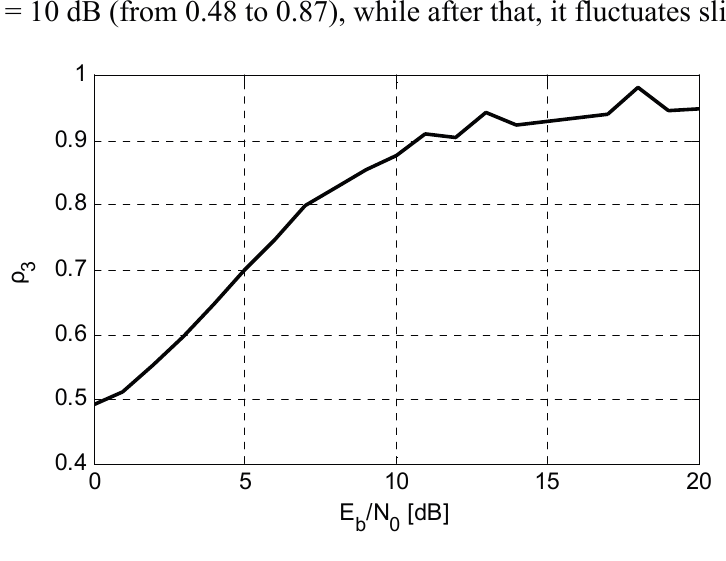
Figure 3. The correlation degree of SIC, DEC, and MMSE detectors, when K =